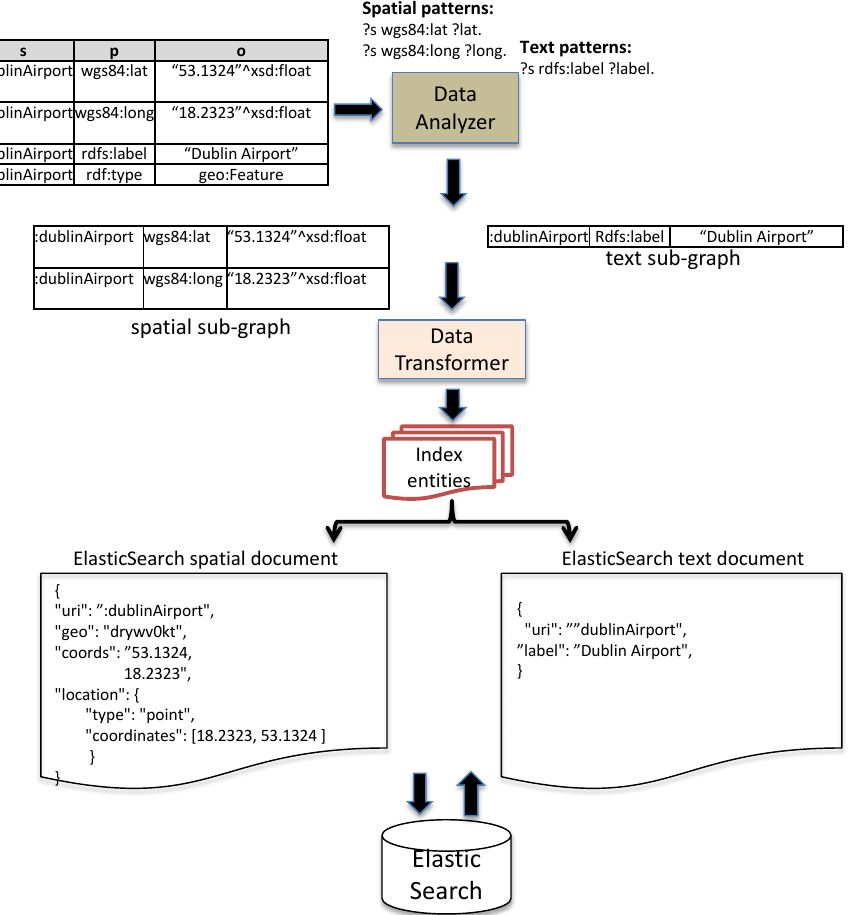
Figure 2. Transform spatial and text sub-graphs to ElasticSearch